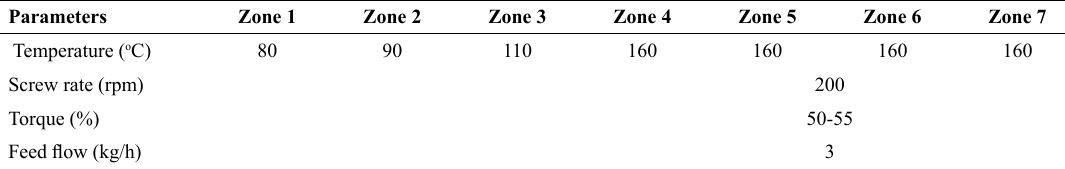
Table 2. Processing parameters for neat PCL and compounds. Parameters